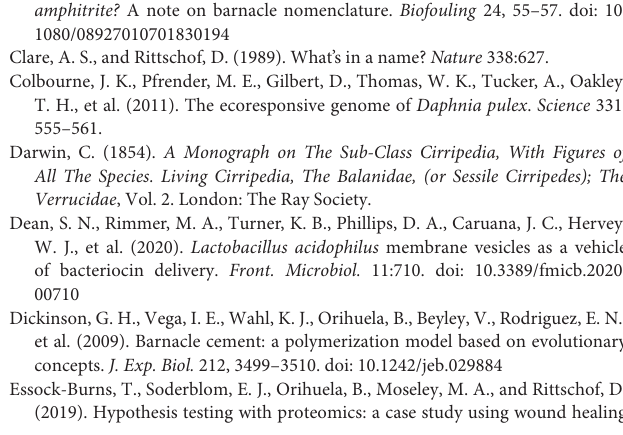
Supplementary Figure 1 | Immunoblot analysis of A. amphitrite adhesive with the polyclonal antibody α -AaCP19-1. Supplementary Figure 2 | Fluorescence confocal images of bisected A. amphitrite demonstrating no fluorescent bleed-through in the CY5 (red) channel. Supplementary Figure 3 | Cy5-labeled secondary antibody controls on A. amphitrite sections. Supplementary Figure 4 | Transverse A. amphitrite sections of sub-mantle and longitudinal canal tissue stained with either Cy5-conjugated α -AaCP19-1 or α -AaCP43-1. Supplementary Figure 5 | Transverse A. amphitrite sections stained with Cy5-conjugated α -AaCP19-1 highlighting different tissues with positive signal. Supplementary Figure 6 | Transverse A. amphitrite sections stained with Cy5-conjugated α -AaCP43-1 highlighting various tissue linings with positive signal. Supplementary Table 1 | List of AaCP19-1 and AaCP43-1 peptide sequences submitted for targeted fragmentation. Supplementary File 1 | Word document with a detailed description of the Mass Spectrometry